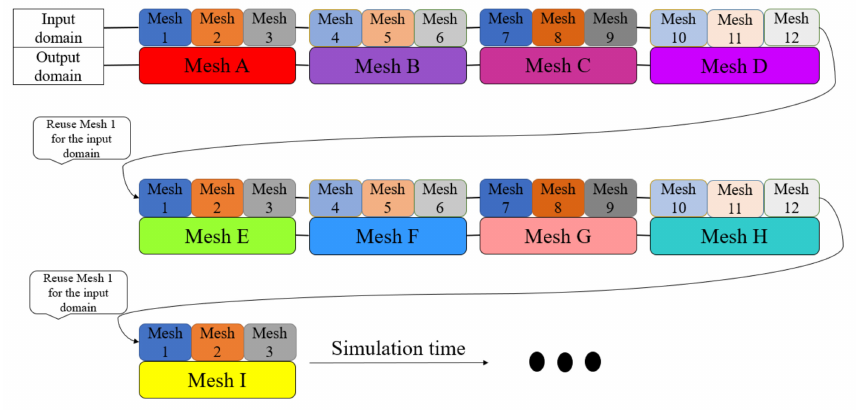
Figure 3. Flowchart of the implemented mesh handling